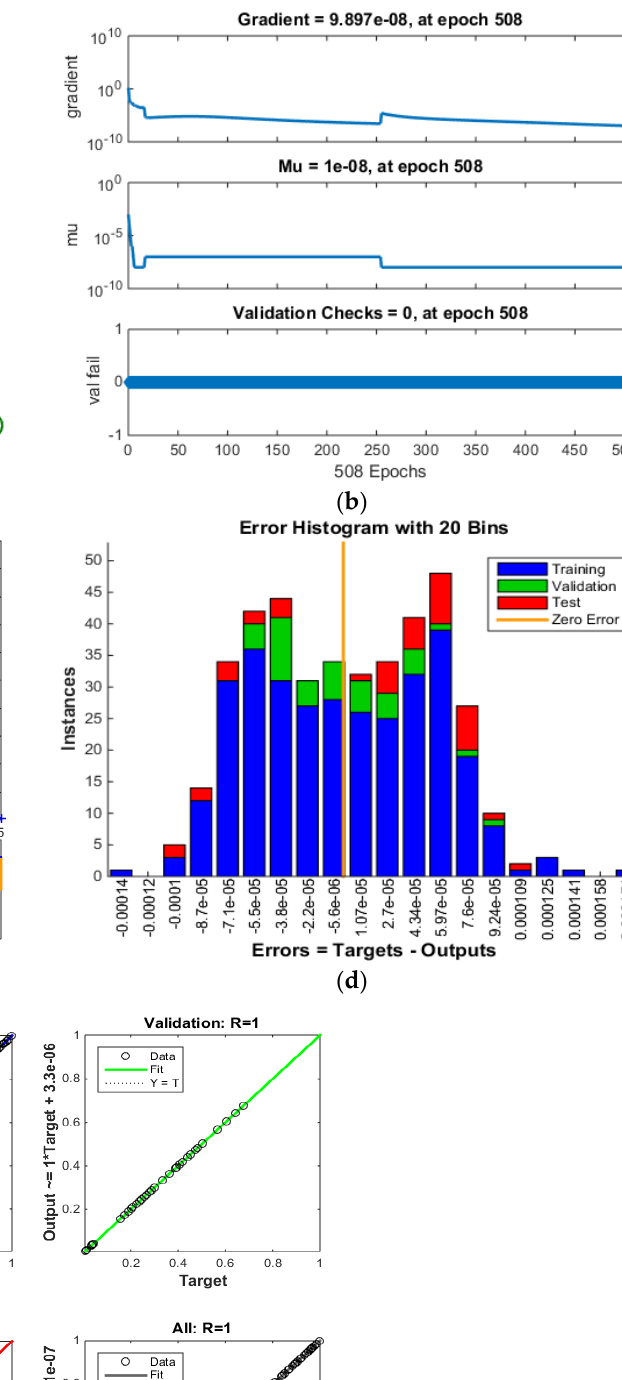
Figure 7. Graphic representation for designed LMT-ABPNN for solving cases of 𝛽 for 𝜃(𝜂) of MHD-SGFM. ( a ) MSE Result, ( b ) Results of the transition state, ( c ) Fitness of the curve, ( d ) Histogram for error analysis, ( e ) Regression.